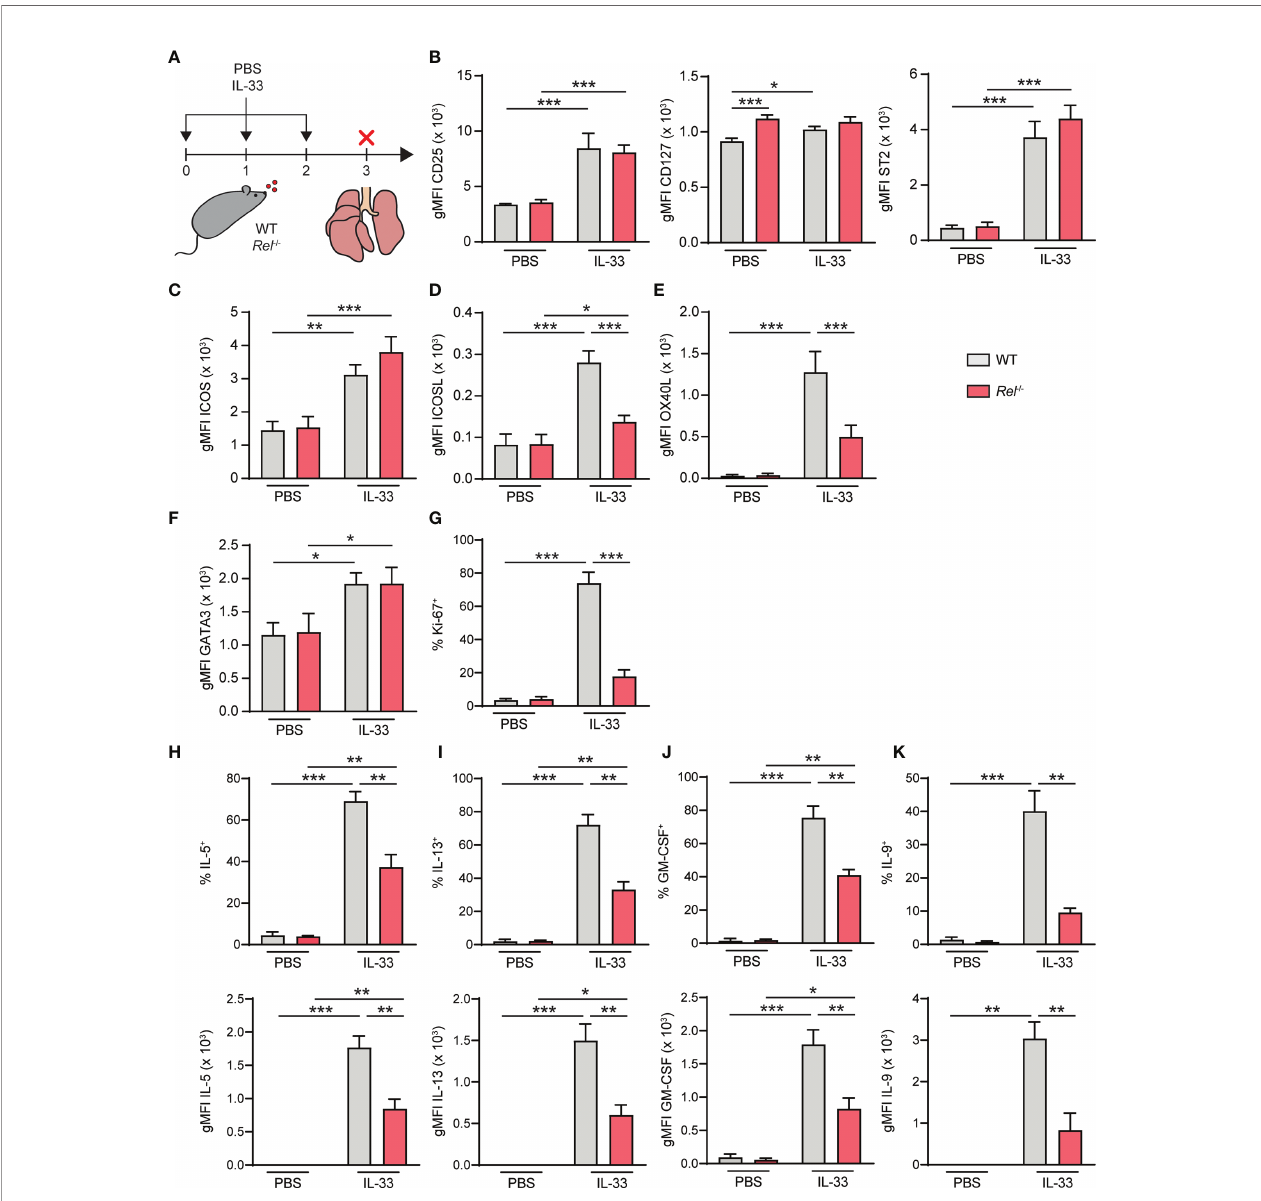
FIGURE 7 | c-Rel drives group 2 innate lymphoid cell (ILC2) effector responses during IL-33-induced allergic airway in fl ammation. (A) Wild-type (WT) and Rel − / − mice were challenged intranasally for 3 days (days 0, 1, and 2) with phosphate-buffered saline (PBS) or IL-33 (500 ng/mouse). Mice were sacri fi ced, and lungs were analyzed 24 h after the last administration. Flow cytometry analysis of surface expression levels of (B) CD25, CD127, and ST2, (C) ICOS, (D) ICOSL, and (E) OX40L, and intracellular expression levels of (F) GATA3 in lung ILC2s following intranasal challenge of WT (gray bars) and Rel − / − (red bars) mice. (G) Frequencies of Ki-67 + WT (gray bars) and Rel − / − (red bars) lung ILC2s following in vivo challenge. Analysis of intracellular expression of (H) IL-5, (I) IL-13, (J) granulocyte-macrophage colony-stimulating factor (GM-CSF), and (K) IL-9 in WT (gray bars) and Rel − / − (red bars) in lung ILC2s following intranasal PBS or IL-33 challenge and ex vivo restimulation with phorbol myristate acetate (PMA)/ionomycin. Frequencies of cytokine-expressing cells are depicted in the top panel; and expression levels, measured as gMFI, are shown in the bottom panel. Data points are representative of two independent experiments with two biological replicates for each stimulation condition. Data are shown as mean ± SD with *p < 0.05, **p < 0.01, and ***p < 0.001 as determined by two-tailed t-test (unpaired). gMFI, geometric mean fl uorescence